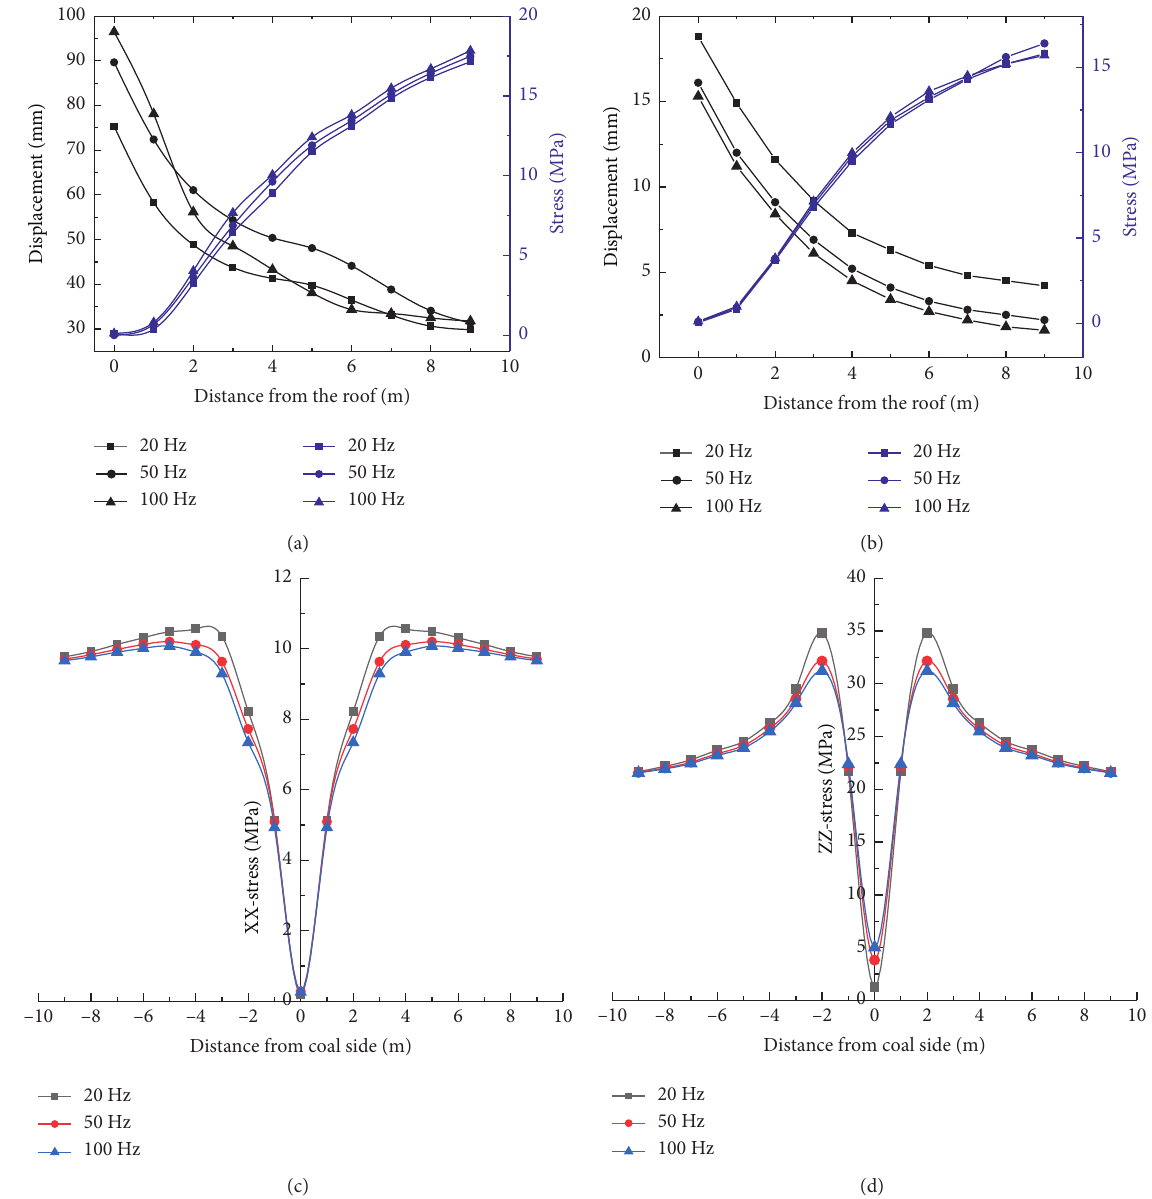
Figure 11: Deformation law of surrounding rock under different disturbance